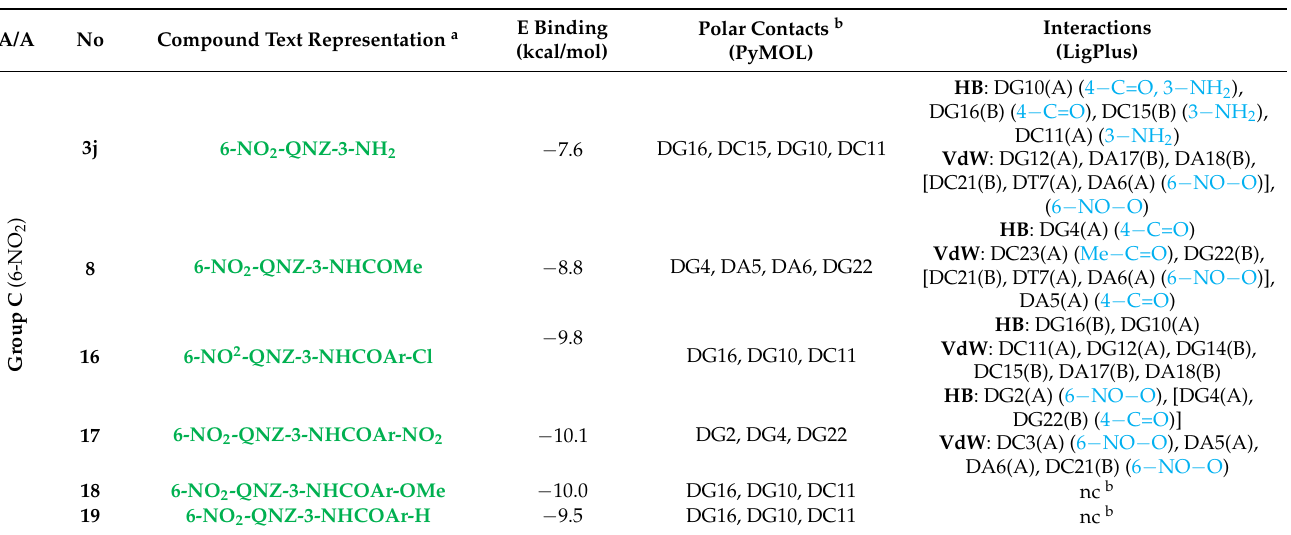
Table 3. Energy binding calculations towards DNA “in silico” of selected groups of compounds. Group